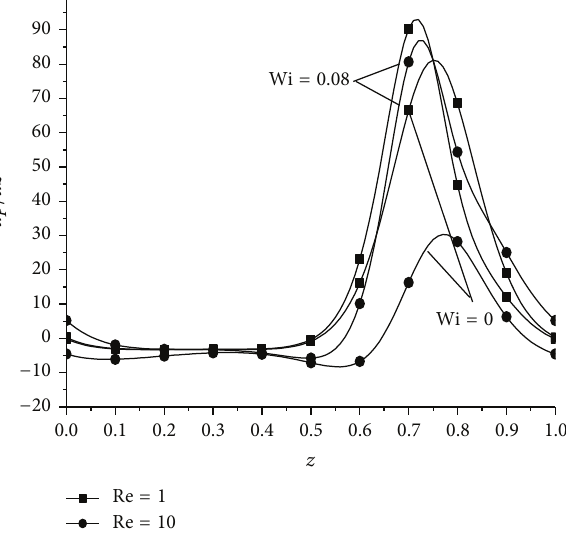
Figure 8: Variation of wall vorticity 𝜂 𝜖 𝑧 versus 𝑧 with different values of 𝜖 and Re at Wi = 0.01 , 𝛿 = 0.1 , 𝑄 = 1 , and 𝜙 = 0.4 .